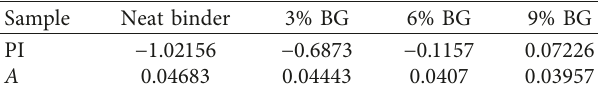
Figure 4: Effect of BG addition on penetration and softening point values. Table 5: Penetration index (PI) of BG-modified bitumen.